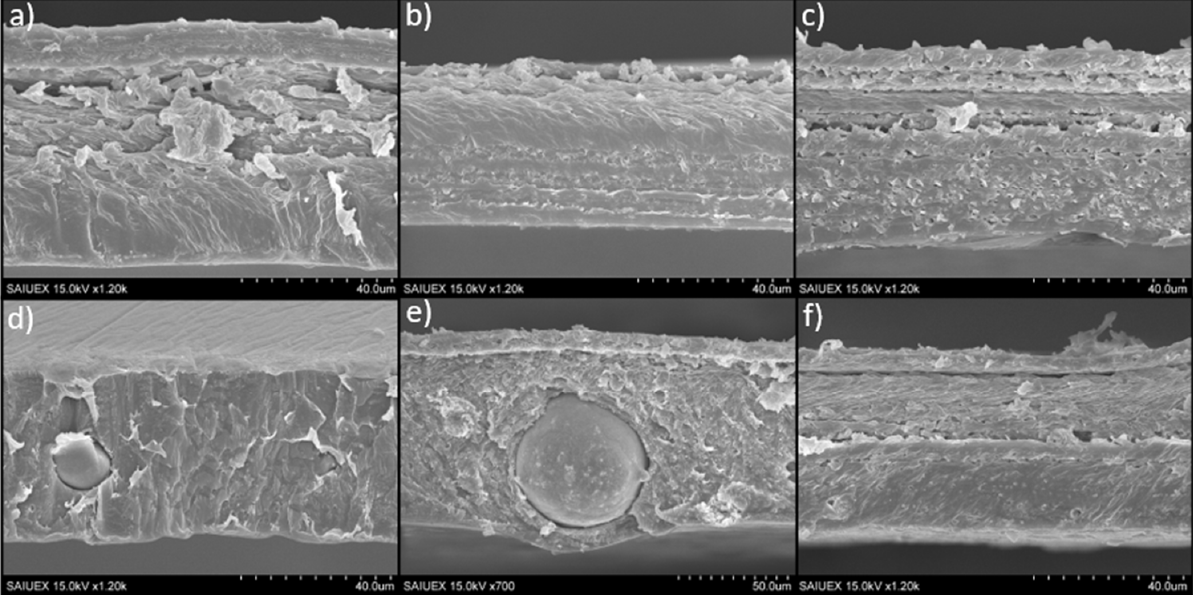
Figure 4. Cross-section images of S-PLA-0,0 ( a ), S-PLA-0,1 ( b ), S-PLA-0,10 ( c ), S-PLA-3,0 ( d ), S-PLA-3,1 ( e ) and S-PLA-3/10 ( f ) films.